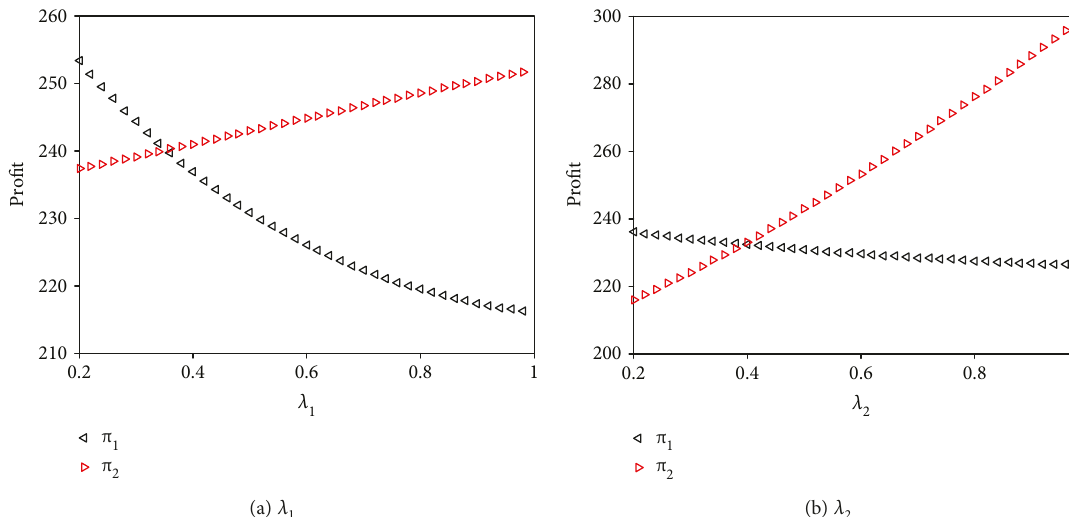
Figure 11: The in fl uence of fairness concern level on the utilities of the two retailers.